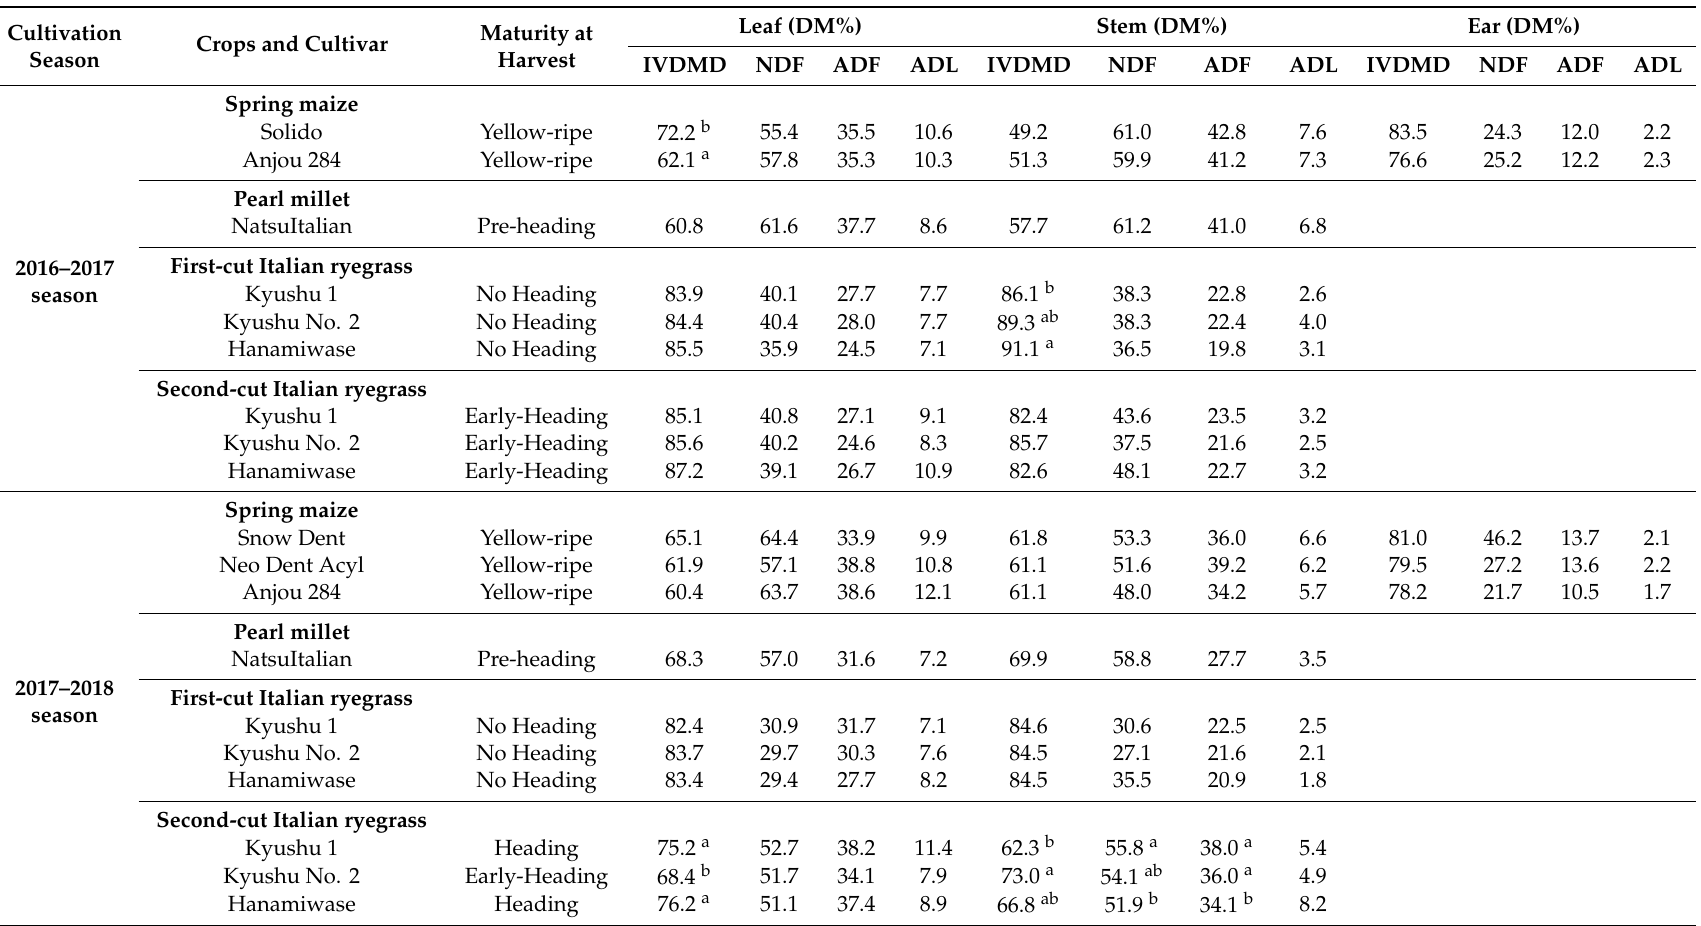
Table 2. Digestibility and fiber concentrations of spring maize, pearl millet and Italian ryegrass in the 2016–2017 and 2017–2018 seasons.